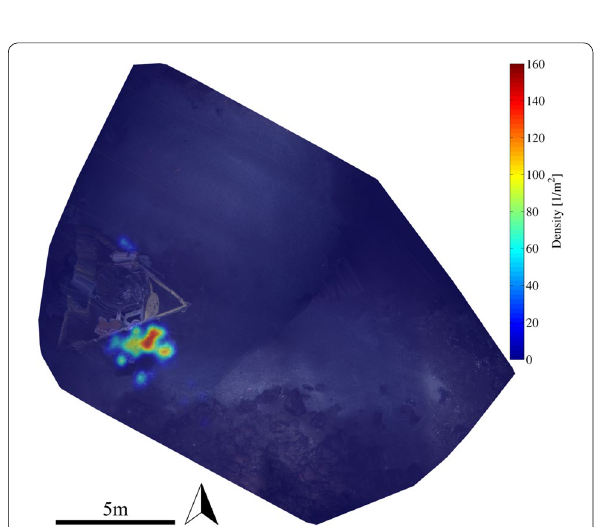
Fig. 9 Top view of the C0016B artificial hydrothermal vent with the density map of S. crosnieri overlaid